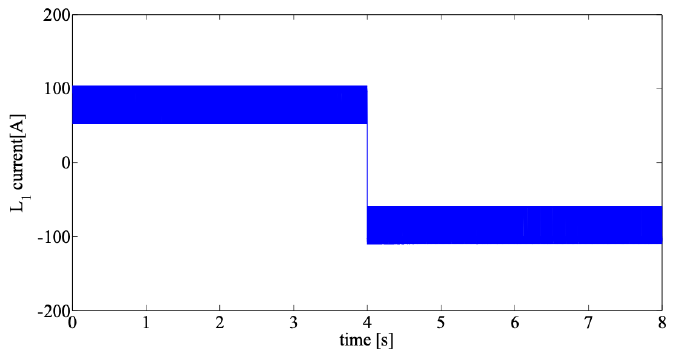
Figure 16. Magnetizing current dynamic behavior (case B).